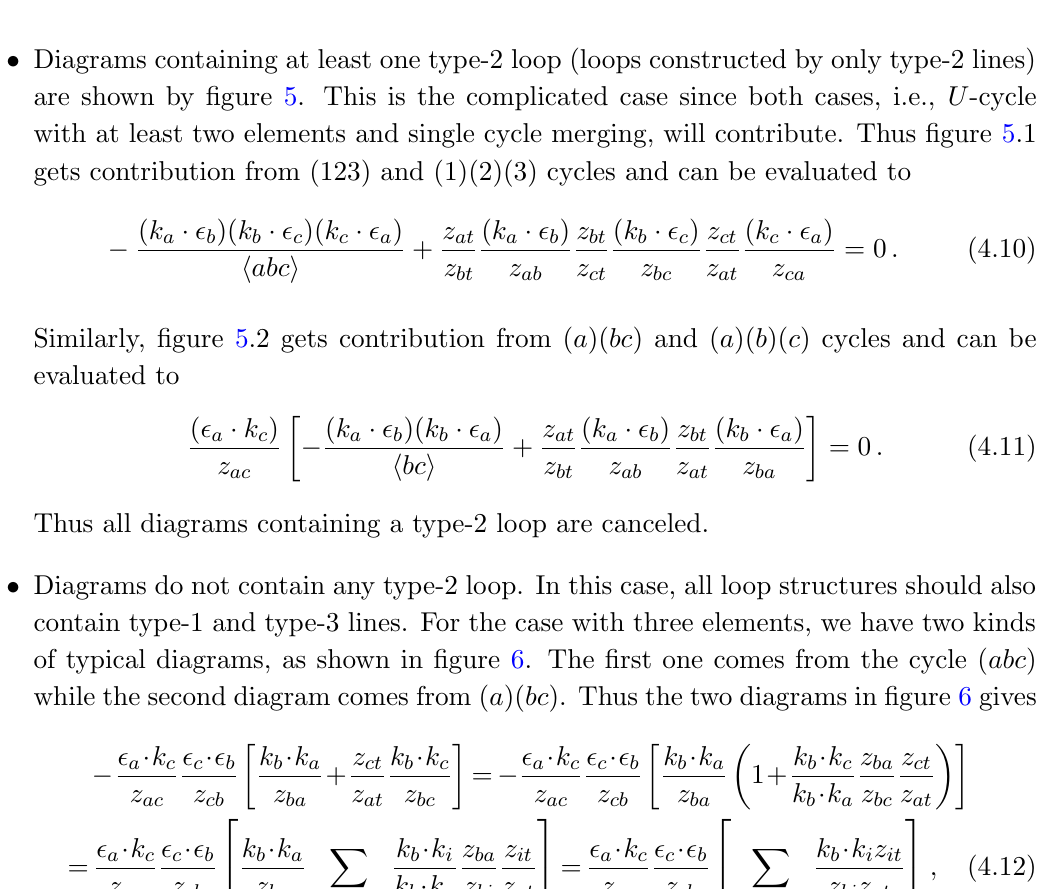
Figure 6 . Diagrams contributing to double pole, which contain type-1 and type-3